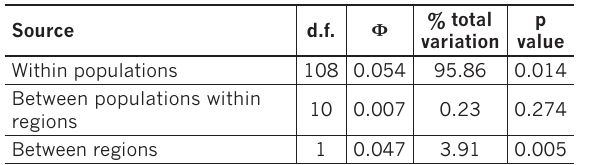
Figure 6. Principal coordinates analysis of ISSR genetic distances from the ‘large’ study showing separation of populations. Popu- lations labeled as in Figure Table 3. Results of the ‘small’ study AMOVA. Regions were spring (S populations), and creek above (C) and below (B) con- fluence with the spring.